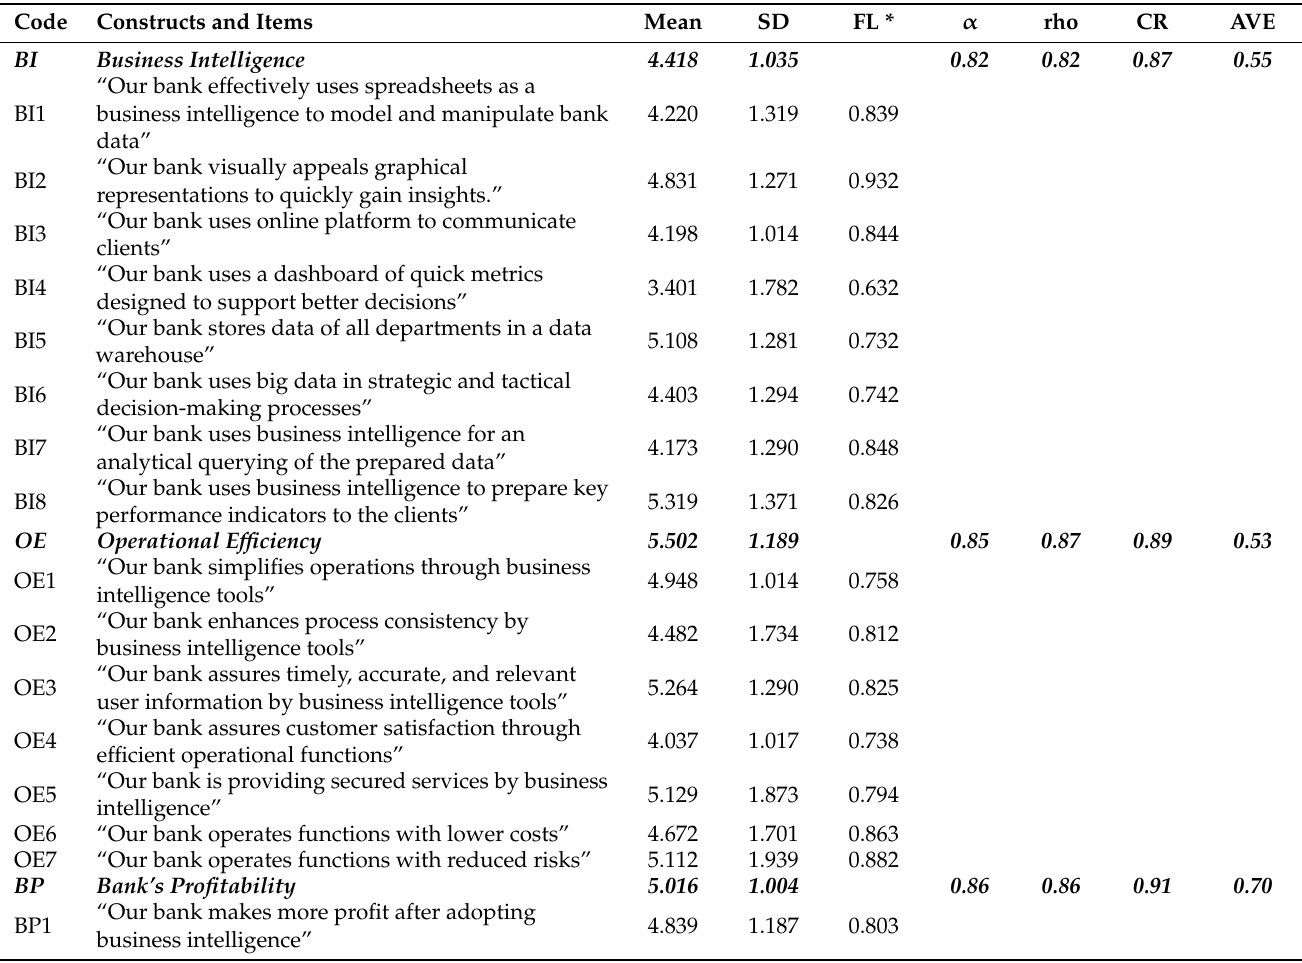
Table 2. Laten variables and measurement